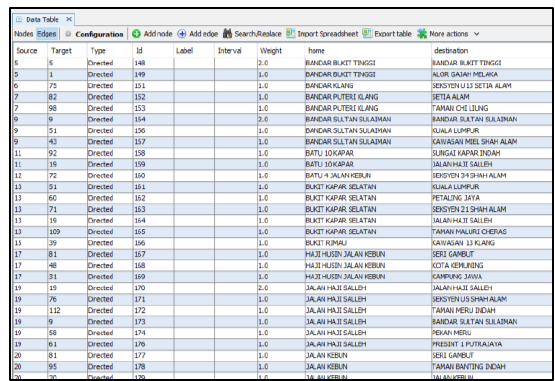
Figure 6. Human Mobility in Edges Data